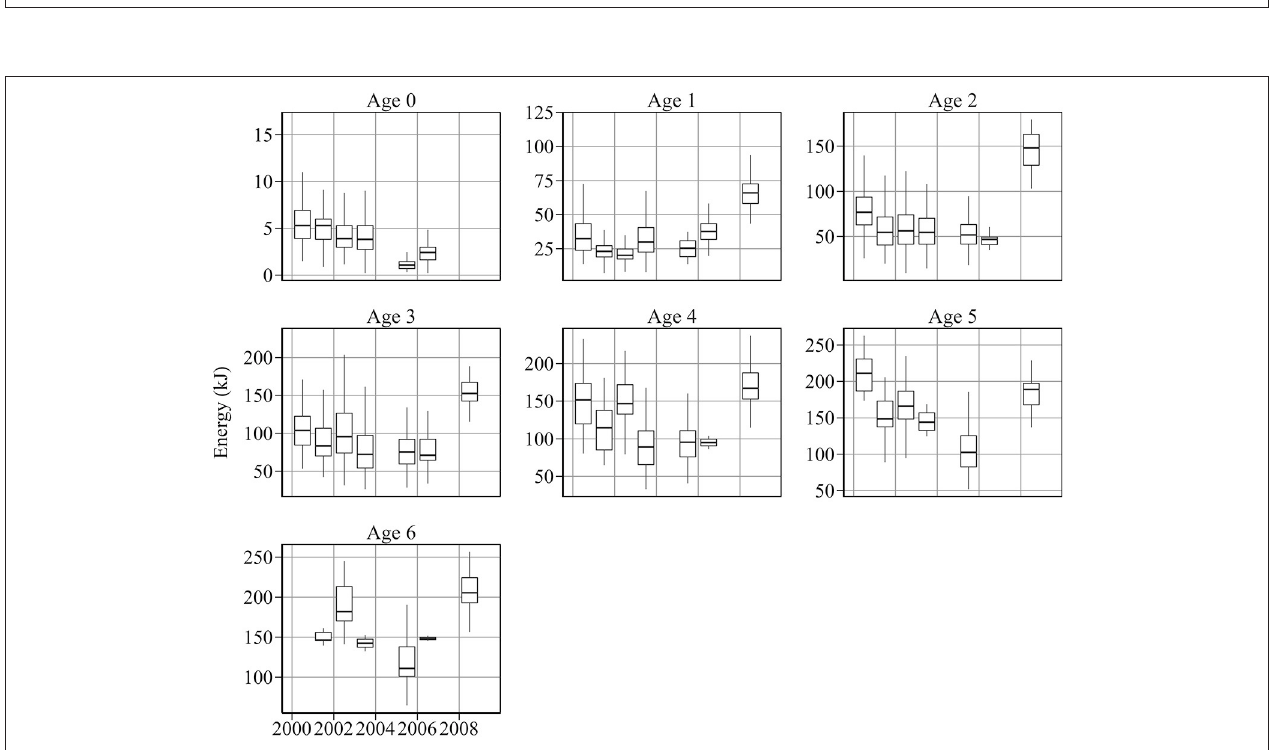
FIGURE 3 | Year-to-year changes in energy content per sandeel. There was a general decline in energy content between 2000 and 2006 for most age groups. Energy per sandeel was relatively high in 2008.